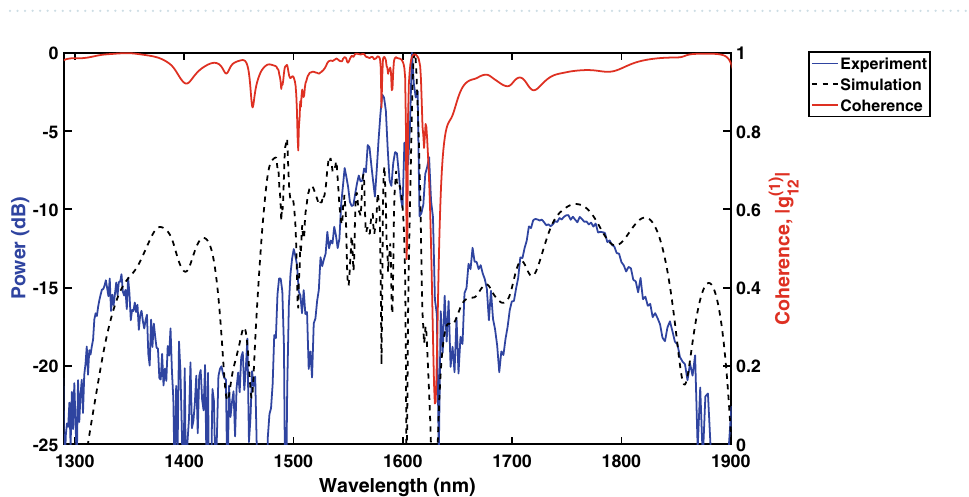
Figure 4. Evolution of the generated supercontinuum of a 700 nm wide AlGaAs-OI waveguide as the energy coupled to the waveguide is increased. The dashed line shows the zero dispersion wavelengths (ZDWs), whilst the dotted line displays the zero third-order dispersion wavelength (ZTODW). A soliton (S) and dispersive wave (DW) pair have also been indicated.